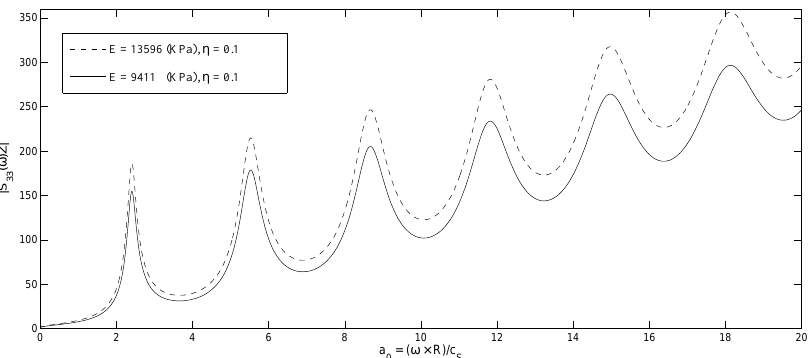
Figure 6. Non-dimensional dynamic stiffness per unit length of an infinite cylinder due to dynamic vertical load in the axial direction for different values of the loss factor η , when E = 9411 × 10 3 and ν = 0.495.